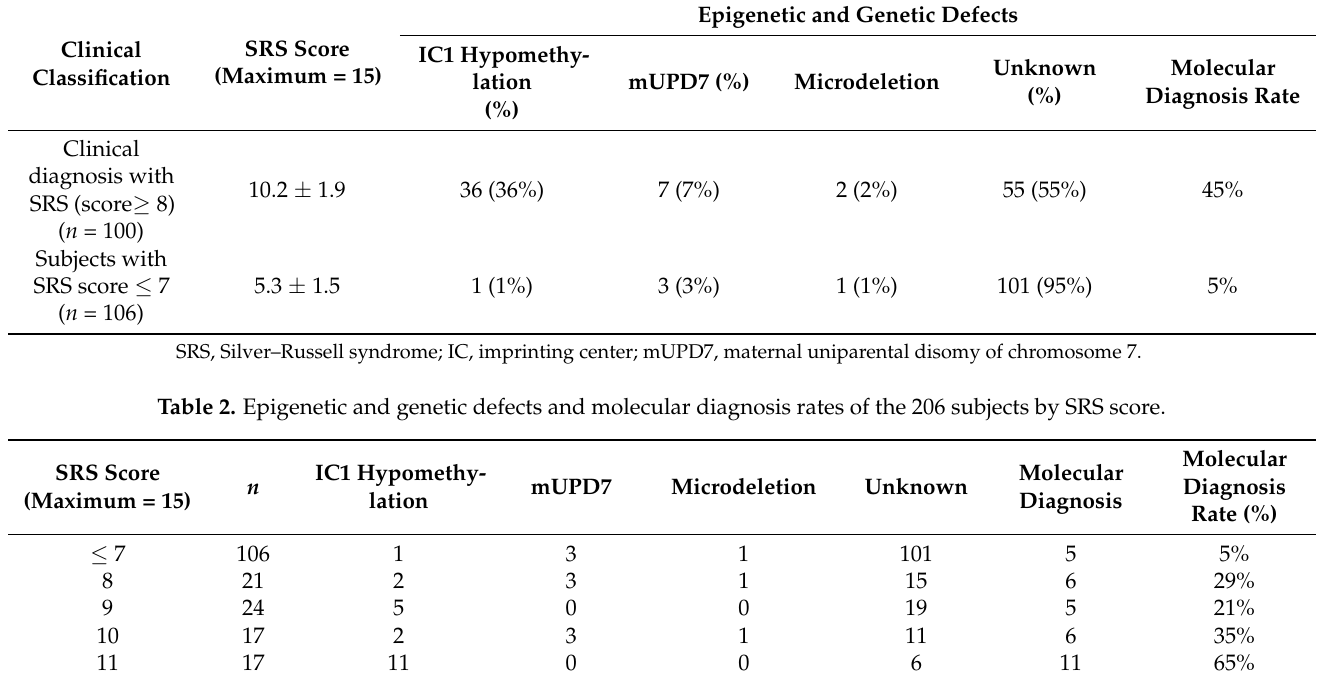
Table 1. Epigenetic and genetic defects of 206 subjects with a clinical diagnosis of SRS (score ≥ 8, n = 100) or SRS score ≤ 7 ( n = 106).